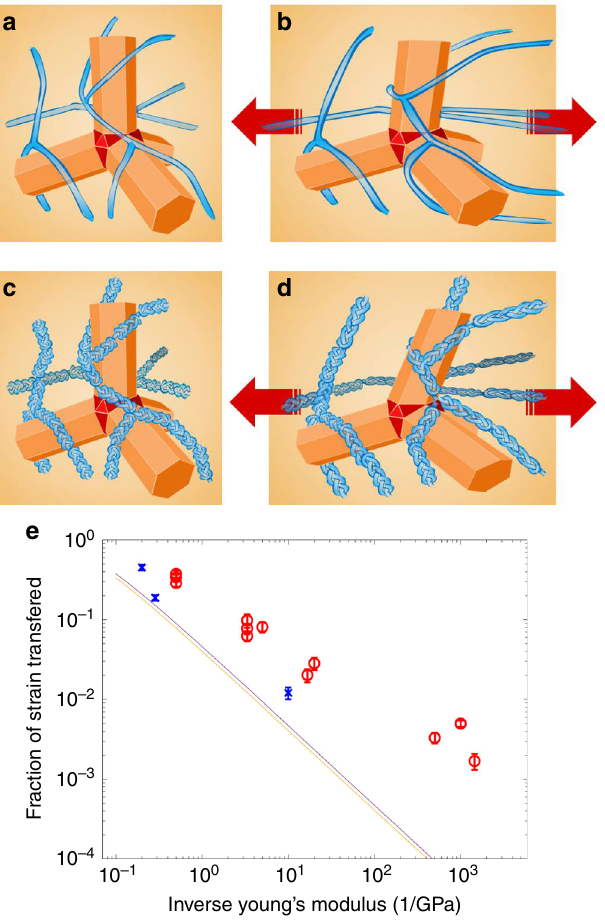
Fig. 5 Polymer-tQD strain transfer ef fi ciency. a Schematic of tQD-polymer interfacial strain transfer. a , b Lower strain transfer ef fi ciency from relatively low Young ’ s modulus polymers to the tQDs, while c and d depict higher strain transfer ef fi ciency from relatively high Young ’ s modulus (higher stiffness depicted as analogous to a braid) polymers to tQDs. e Red circles and blue Xs indicate experimental values. Blue Xs represent systems with varied ligand-tQD surface chemistry. Polymer-tQD strain transfer ef fi ciency as a function of inverse Young ’ s modulus of the polymer material. The plot shows lines that indicate our theoretical Mori-Tanaka model predictions; the yellow line represents the theoretical model with a polymer Poisson ’ s ratio of 0.3, while the purple line represents the theoretical model with a polymer Poisson ’ s ratio of 0.5. Error bars represent SEM and each mean